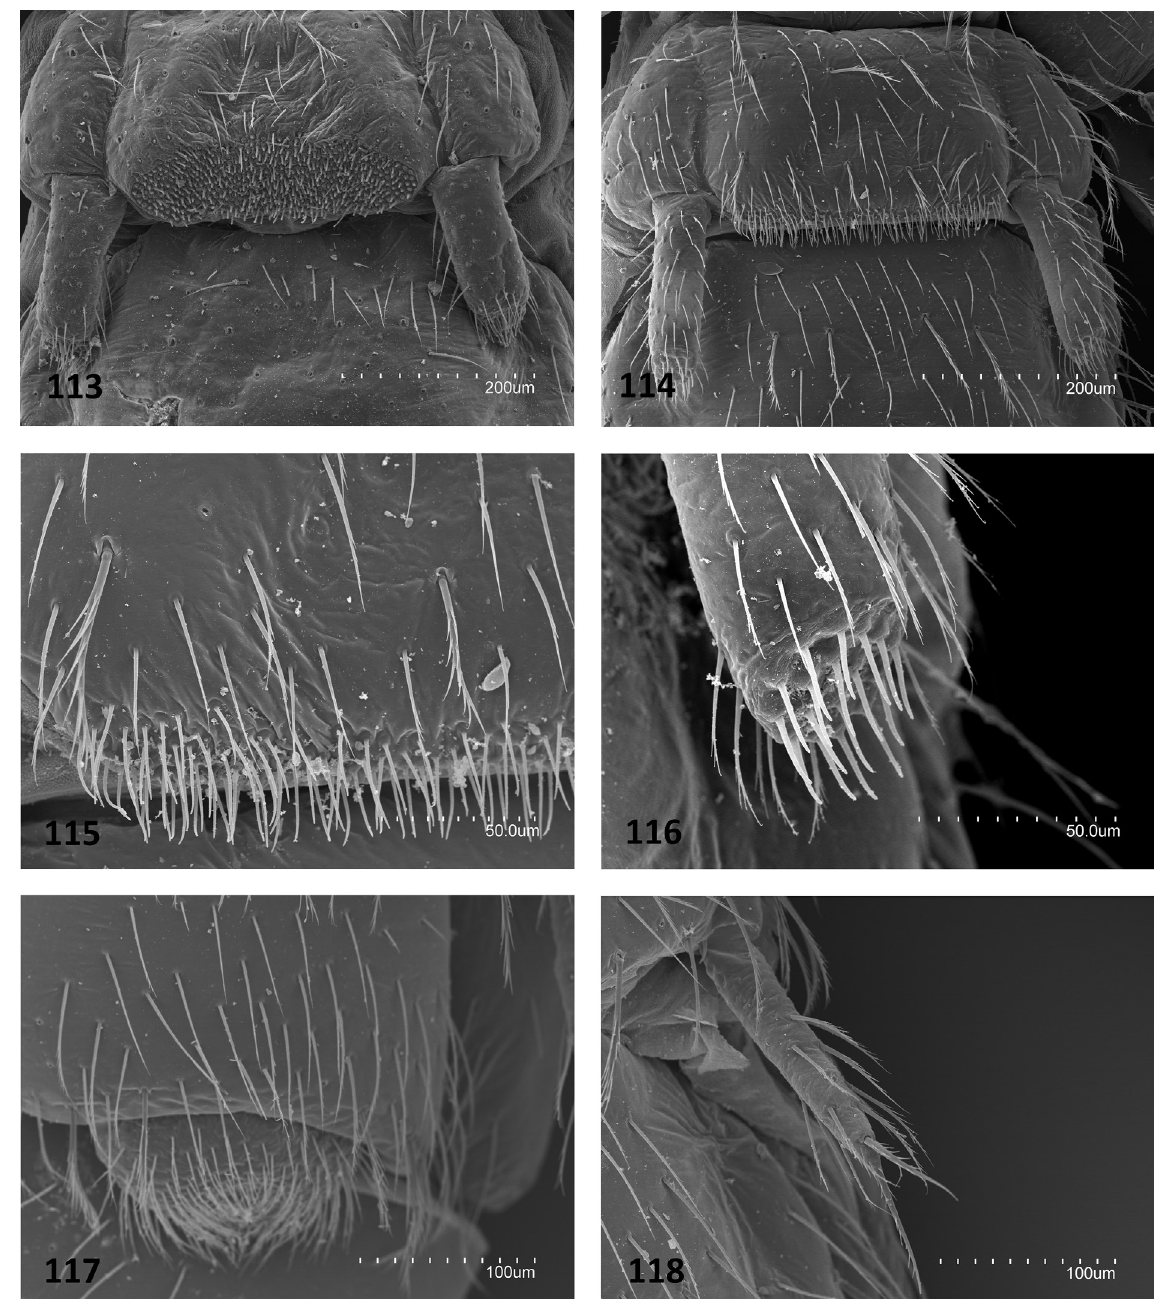
Figs 113–118. Plusiocampa ( Plusiocampa ) lagari Sendra & Condé, 1987, adult ♂♂, from Farallón Cave, Riopar, Albacete, Spain (Coll. AS). 113 . Urosternite I of a large adult ♂. 114 . Urosternite I. 115 . Distal portion of appendage of a urosternite. 116 . Detail of posterior portion of urosternite I with glandular g setae. 117 . Urosternite VIII. 118 . Lateral part of urosternite VII, with 1